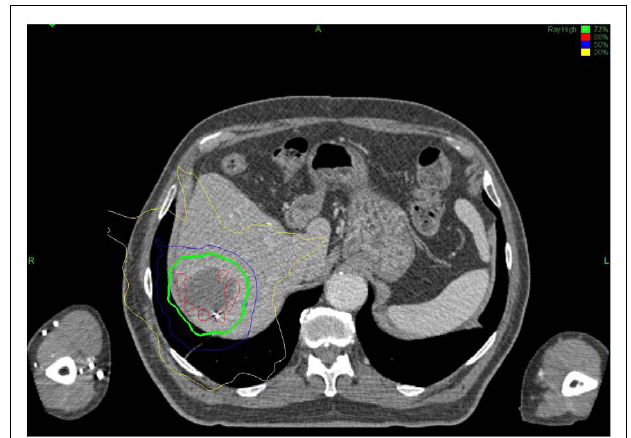
FIGURE 3 |Treatment plan. Red = 88%; green = 73%; blue = 50%; yellow = 20% isodose